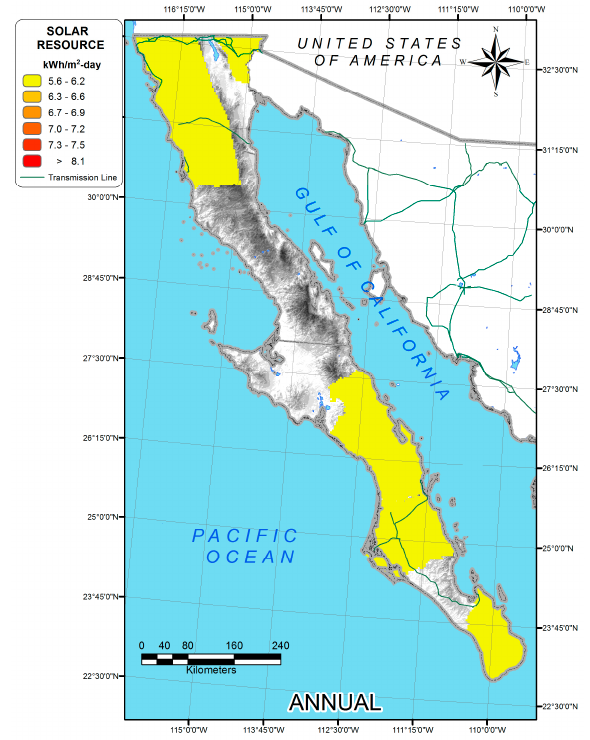
Figure 12. Annual Irradiation at the Baja California Peninsula.